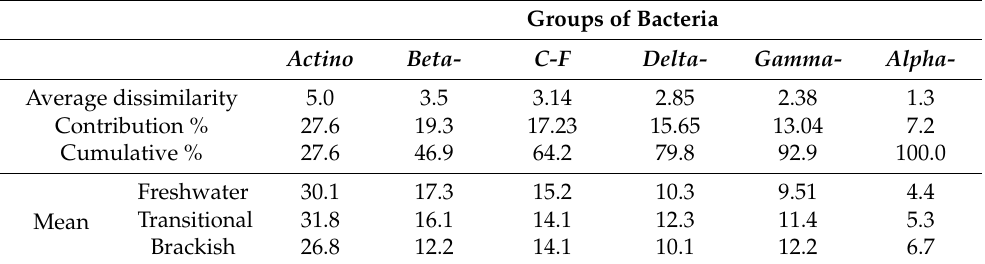
Table 5. Similarity percentage analysis (SIMPER) for coastal lake types based on bacteria group contribu- tion in a Bray–Curtis dissimilarity matrix ( Actino : Actinobacteria ; Beta- : Betaproteobacteria ; C-F : Cytophaga- Flavobacteria ; Delta- : Deltaproteobacteria ; Gamma- : Gammaproteobacteria ; Alpha- : Alphaproteobacteria